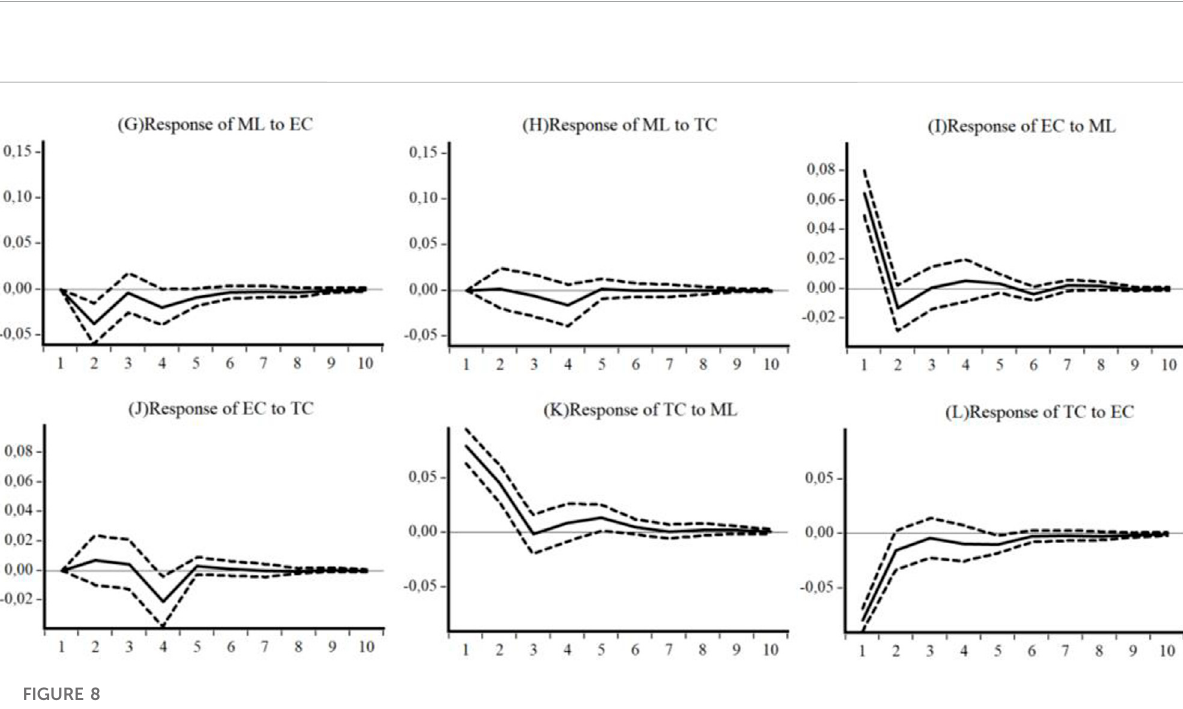
Frontiers in Environmental